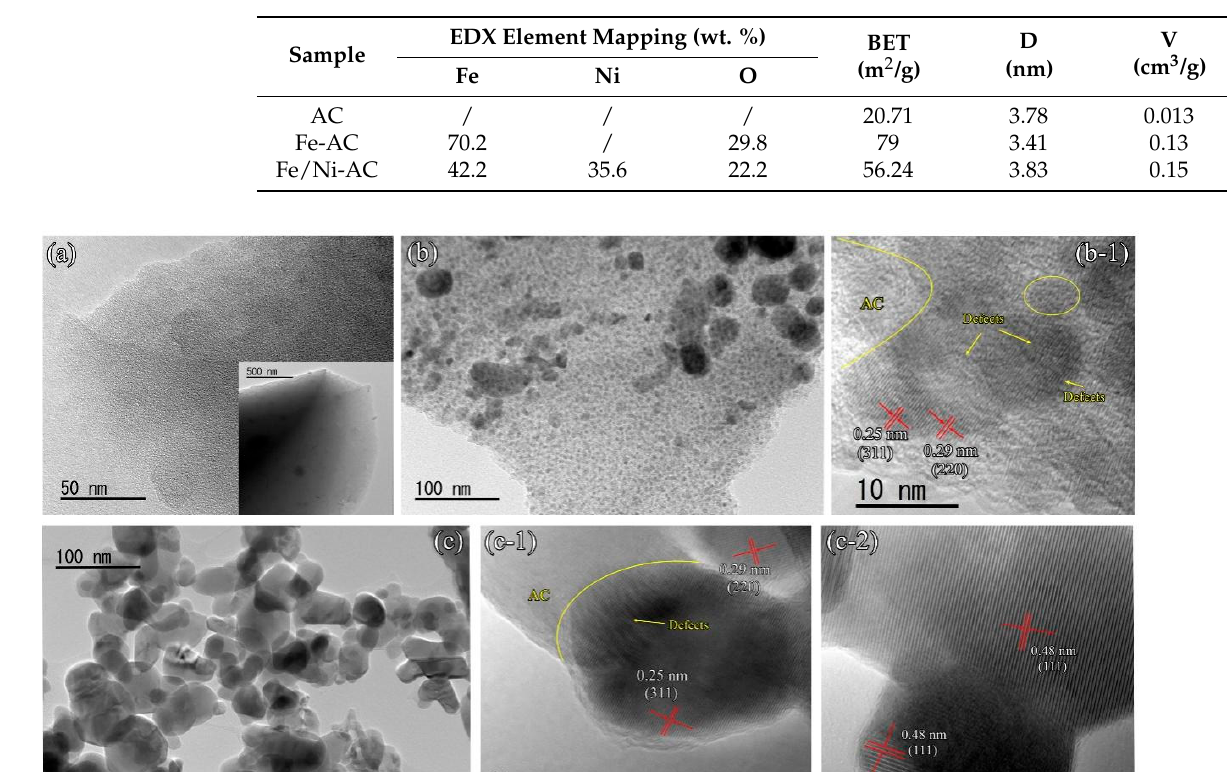
Figure 2. TEM and HRTEM images of ( a ) AC, ( b ) Fe-AC, and ( c ) Fe/Ni-AC. (Inset: the magnification of AC; ( b-1 , c-1 , c-2 ) are different magnification areas in Figure 2b,c, respectively.)